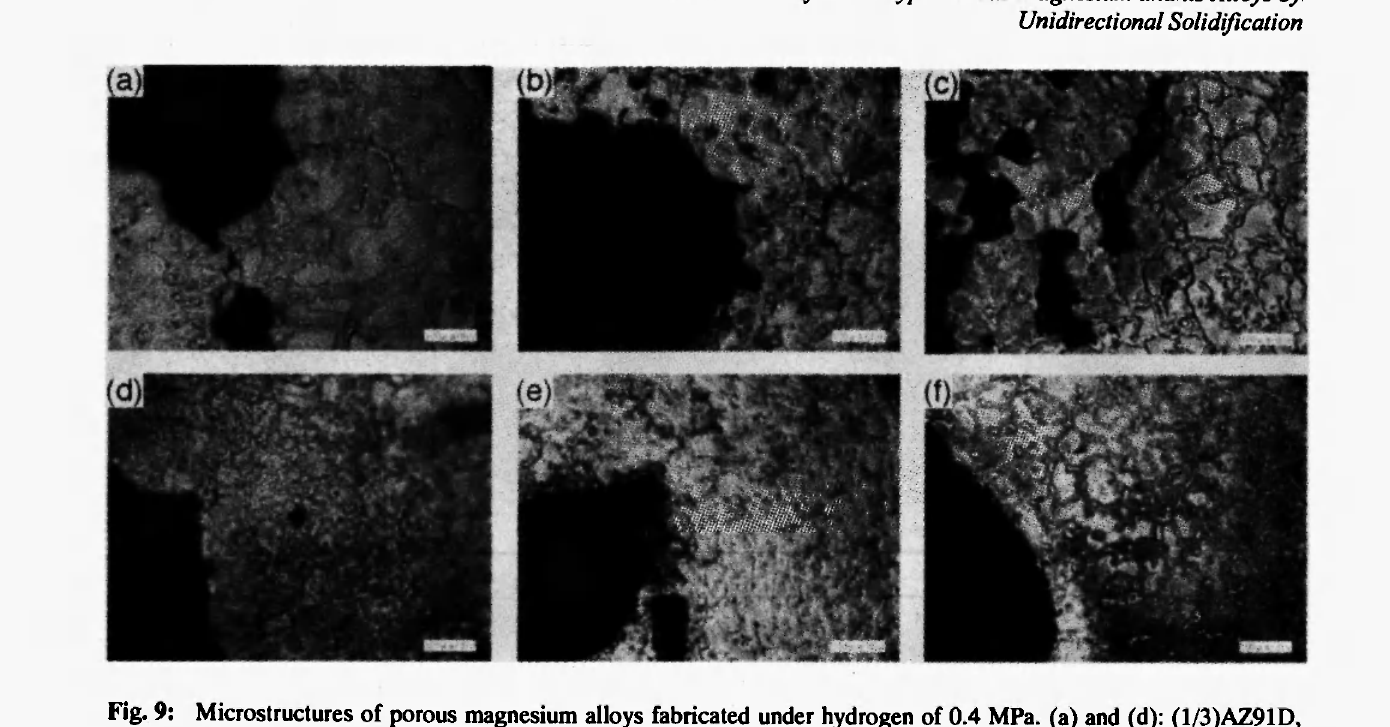
Fig. 9: Microstructures of porous magnesium alloys fabricated under hydrogen of 0.4 MPa. (a) and (d): (1/3)AZ91D, (b) and (e): AZ31B, (c) and (f): AZ91D. The upper pictures ((a), (b), (c)) are at 60 mm height and the lower pictures ((d), (e), (f)) are at 10 mm height from the bottom plane of the ingots.